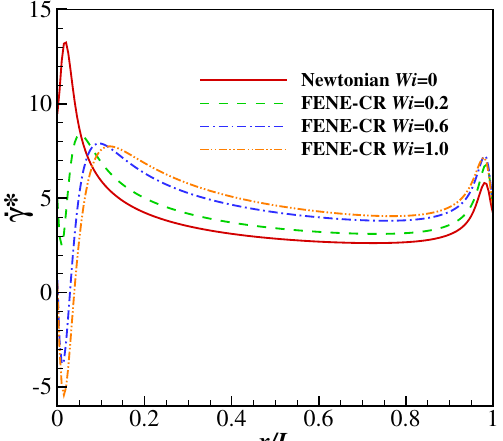
Figure 16. The non-dimensional shear rate ˙ γ ∗ = ∂ u x Wi = 0, 0.2, 0.6 and